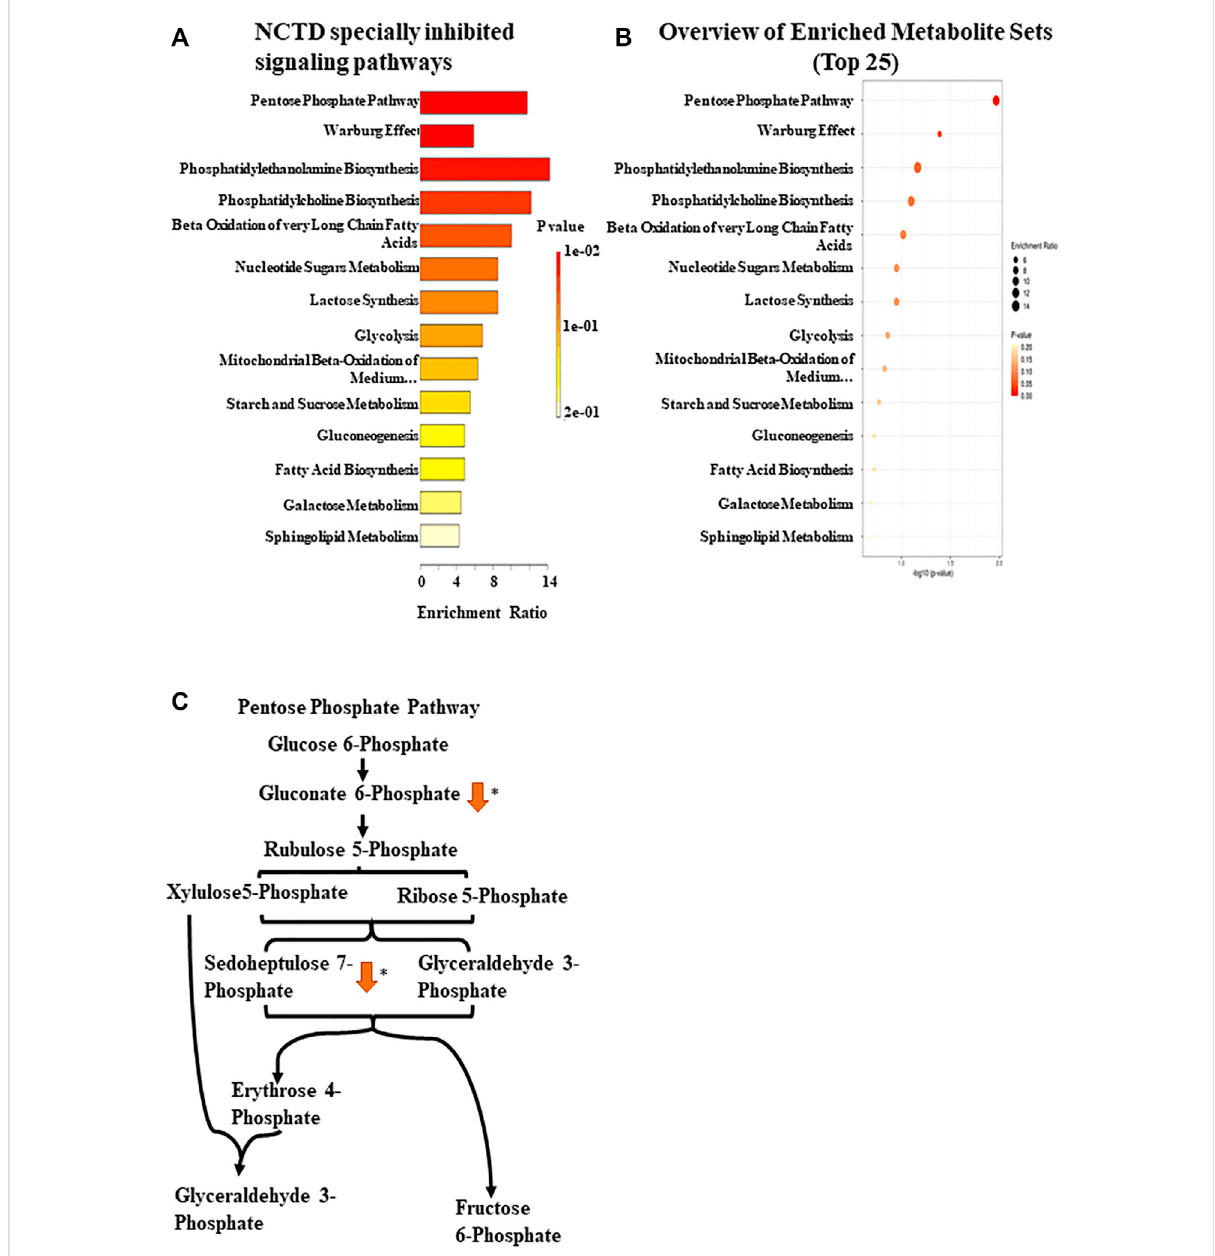
FIGURE 4 Enrichment pathway analysis based on CE-MS. (A) Metabolic pathway enrichment analysis of the metabolites inhibited by NCTD in A375R cells was used by Metaboanalyst 5.0 (https://www.metaboanalyst.ca/). (B) Enrichment ratio of the metabolic pathway. (C) Regulatory mechanism of the pentose phosphate pathway by NCTD. p p <